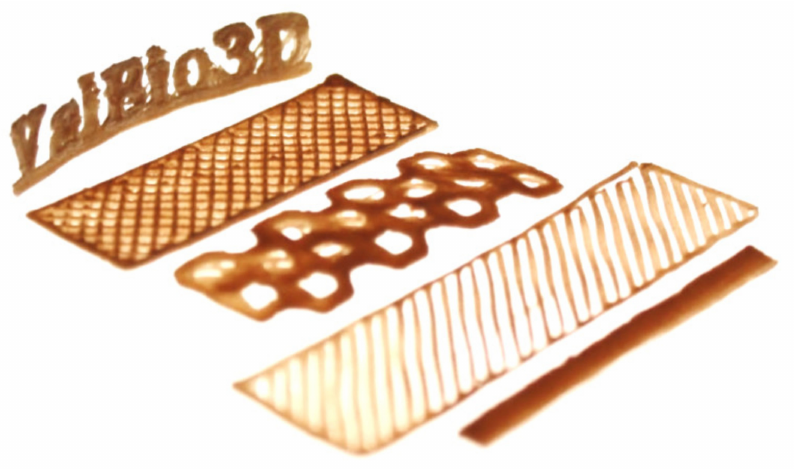
Figure 6. 3D shapes printed with filaments containing BioPE and bagasse fibers (ValBio-3D